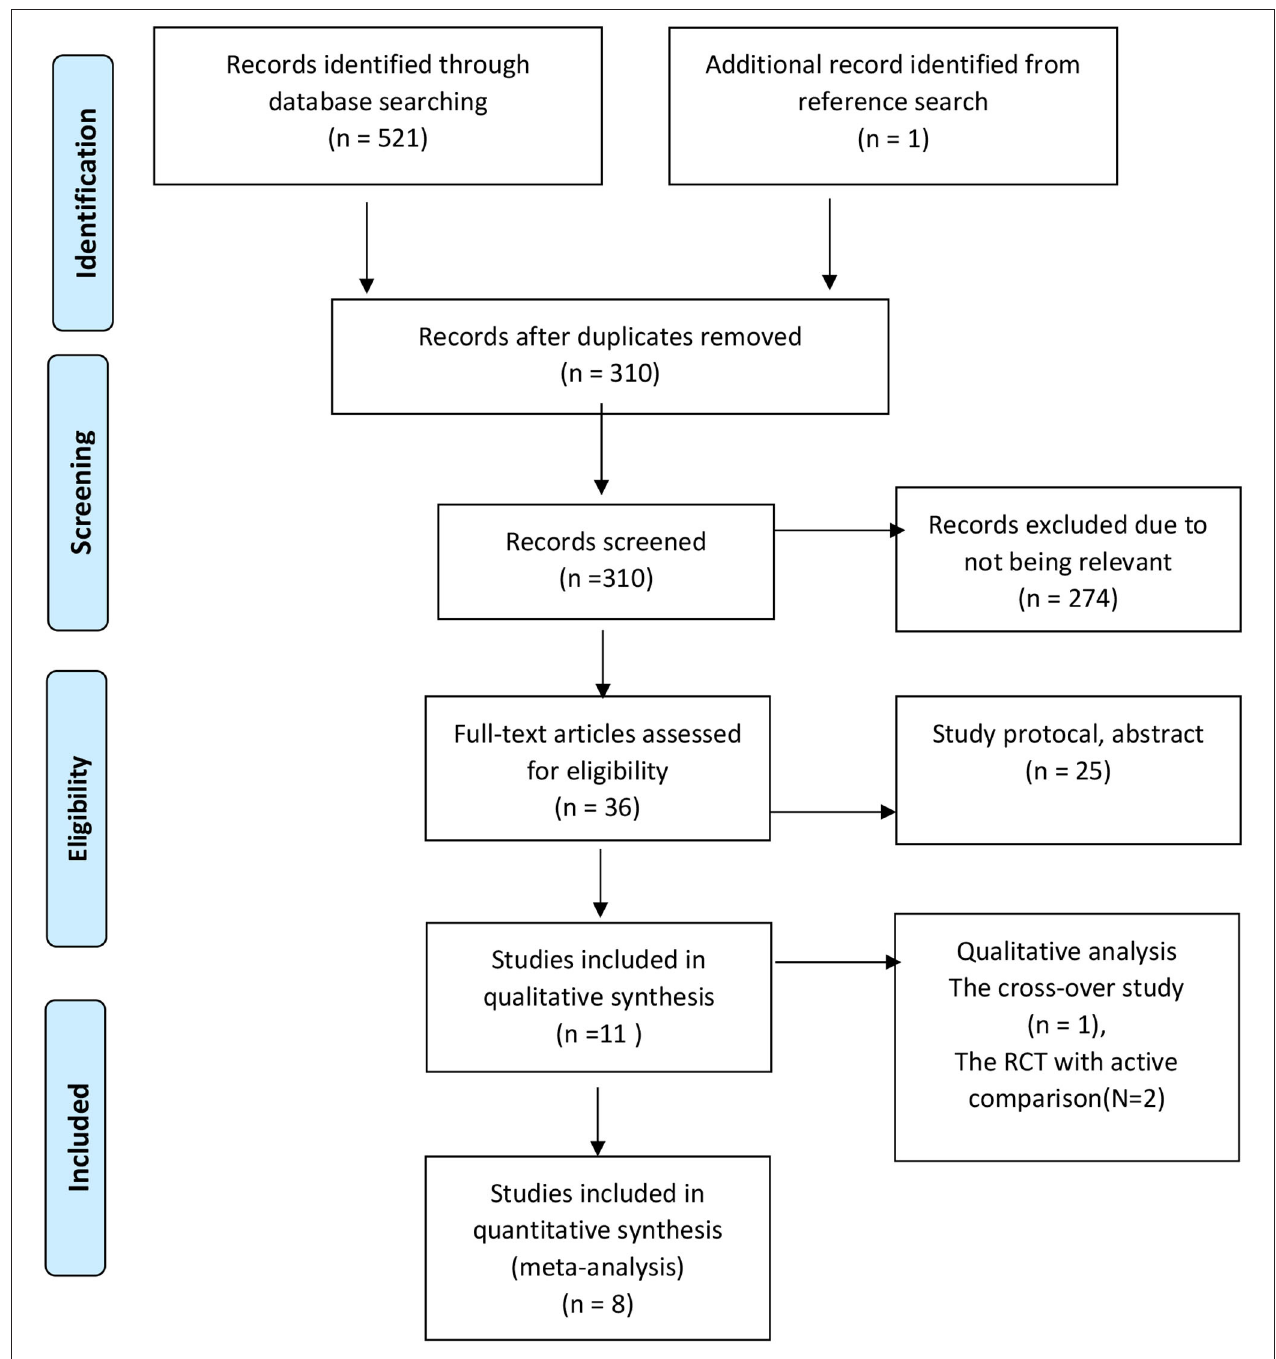
FIGURE 1 | Algorithm of study selection following PRISMA